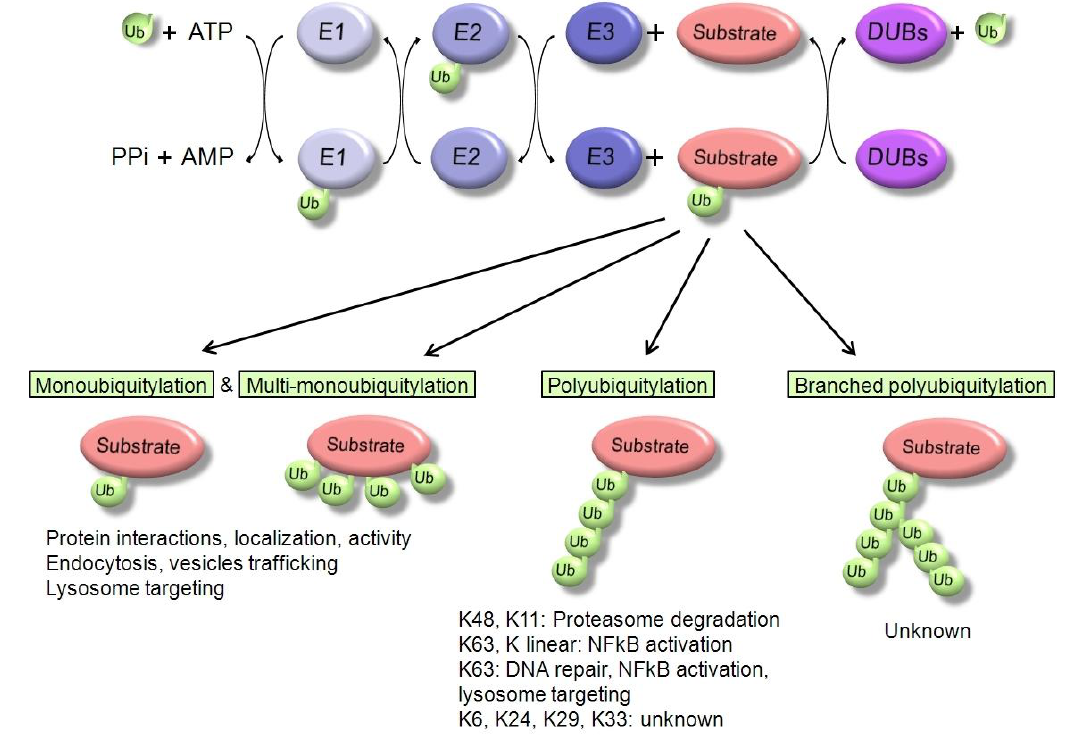
FIGURE 1. The ubiquitylation machinery and associated functions. Before being conjugated to the target protein, ubiquitin needs to go through a three-step process that implicates first the attachment of ubiquitin to a ubiquitin-activating enzyme (E1) via the hydrolysis of one ATP molecule. Subsequently, the ubiquitin is transferred to a conjugating enzyme (E2) and then the ubiquitin ligase (E3) will enable the transfer of ubiquitin to a specific target protein. This process, which leads to monoubiquitylation of the substrate, may be repeated to produce either multimonoubiquitylation or polyubiquitylation of the same protein. This protein modification can be removed by the action of DUBs. These different forms of ubiquitylation, depending on the nature of the target protein, will have miscellaneous